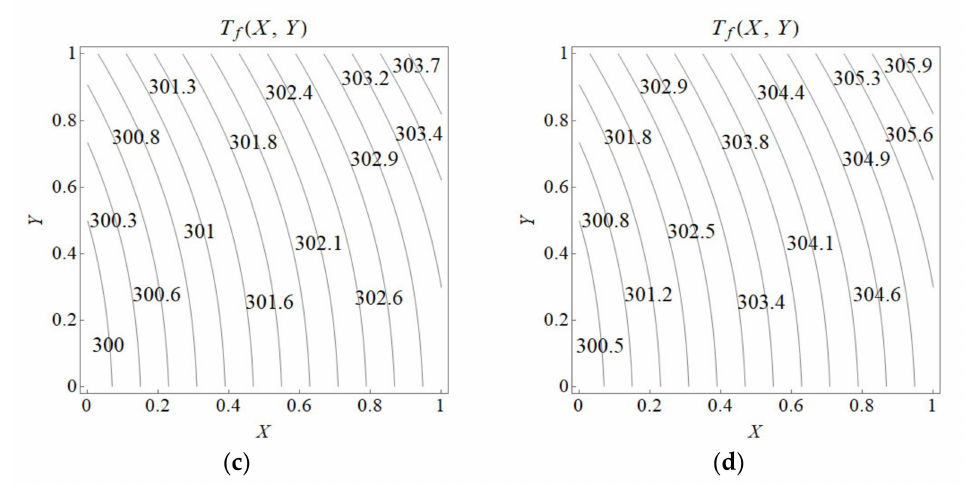
Figure 8. Temperature line plots in Kelvin for Re = 25 in a microchannel. ( a ) 0% volume fraction Al 2 O 3 - Water without viscous dissipation. ( b ) 0% volume fraction Al 2 O 3 -Water with viscous dissipation. ( c ) 4% volume fraction Al 2 O 3 -Water without viscous dissipation. ( d ) 4% volume fraction Al 2 O 3 -Water with viscous dissipation.